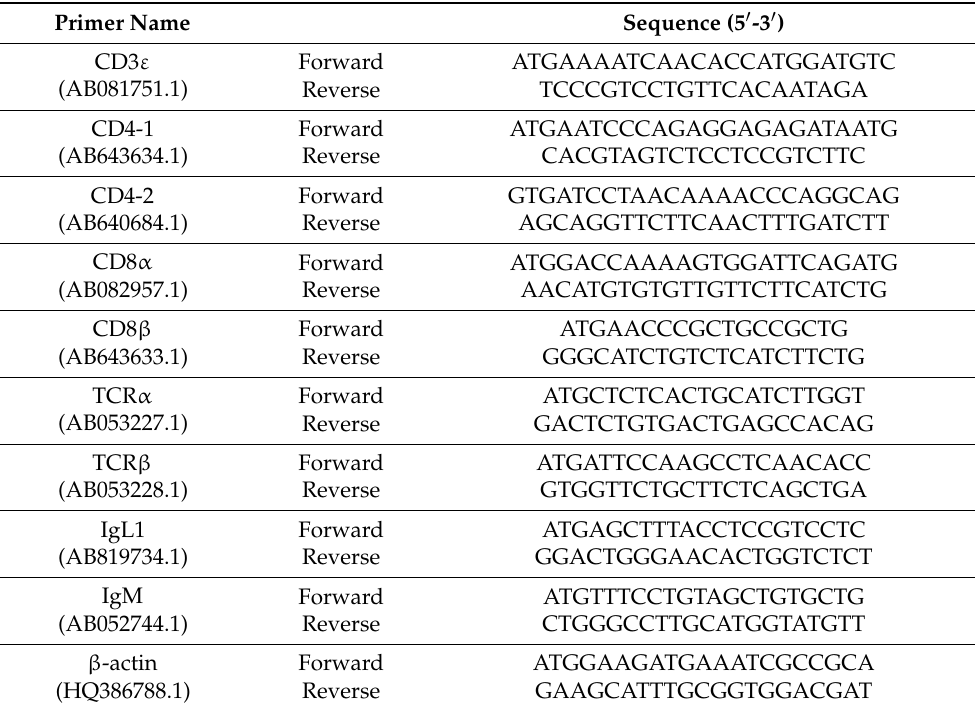
Table 4. Oligonucleotide primer sequences used for RT-PCR